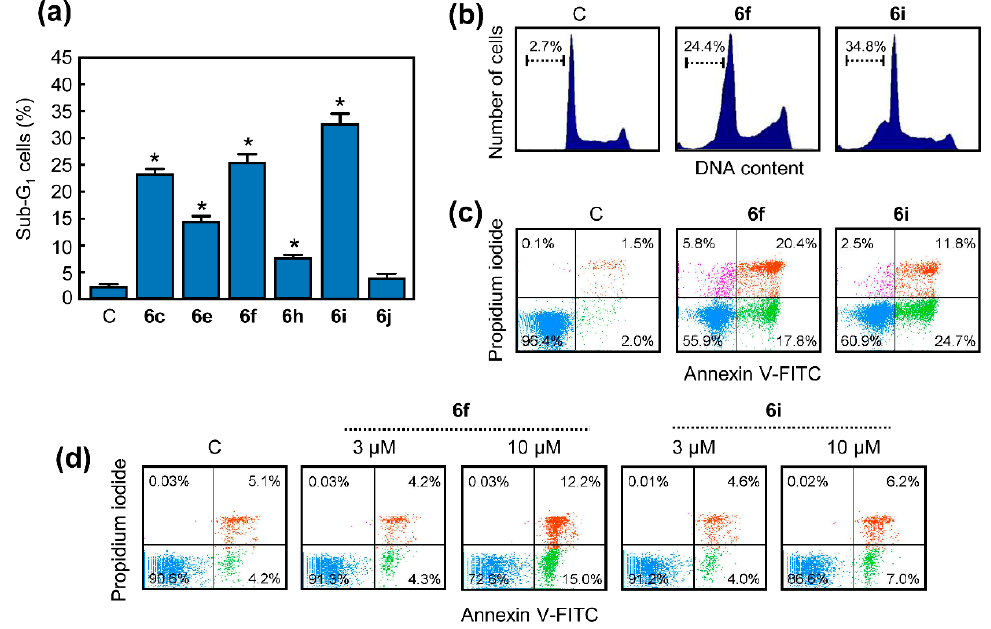
Figure 3. Increase in percentage of apoptotic cells (sub-G 1 fraction) due to hybrid compounds and externalization of phosphatidylserine by compounds 6f and 6i in U-937 cells. ( a ) Cells were incubated with 10 µM of specified chalcone–guanidines for 24 h and apoptotic cells were quantified as percentage of cells in the sub-G 1 region using flow cytometry after propidium iodide staining. *